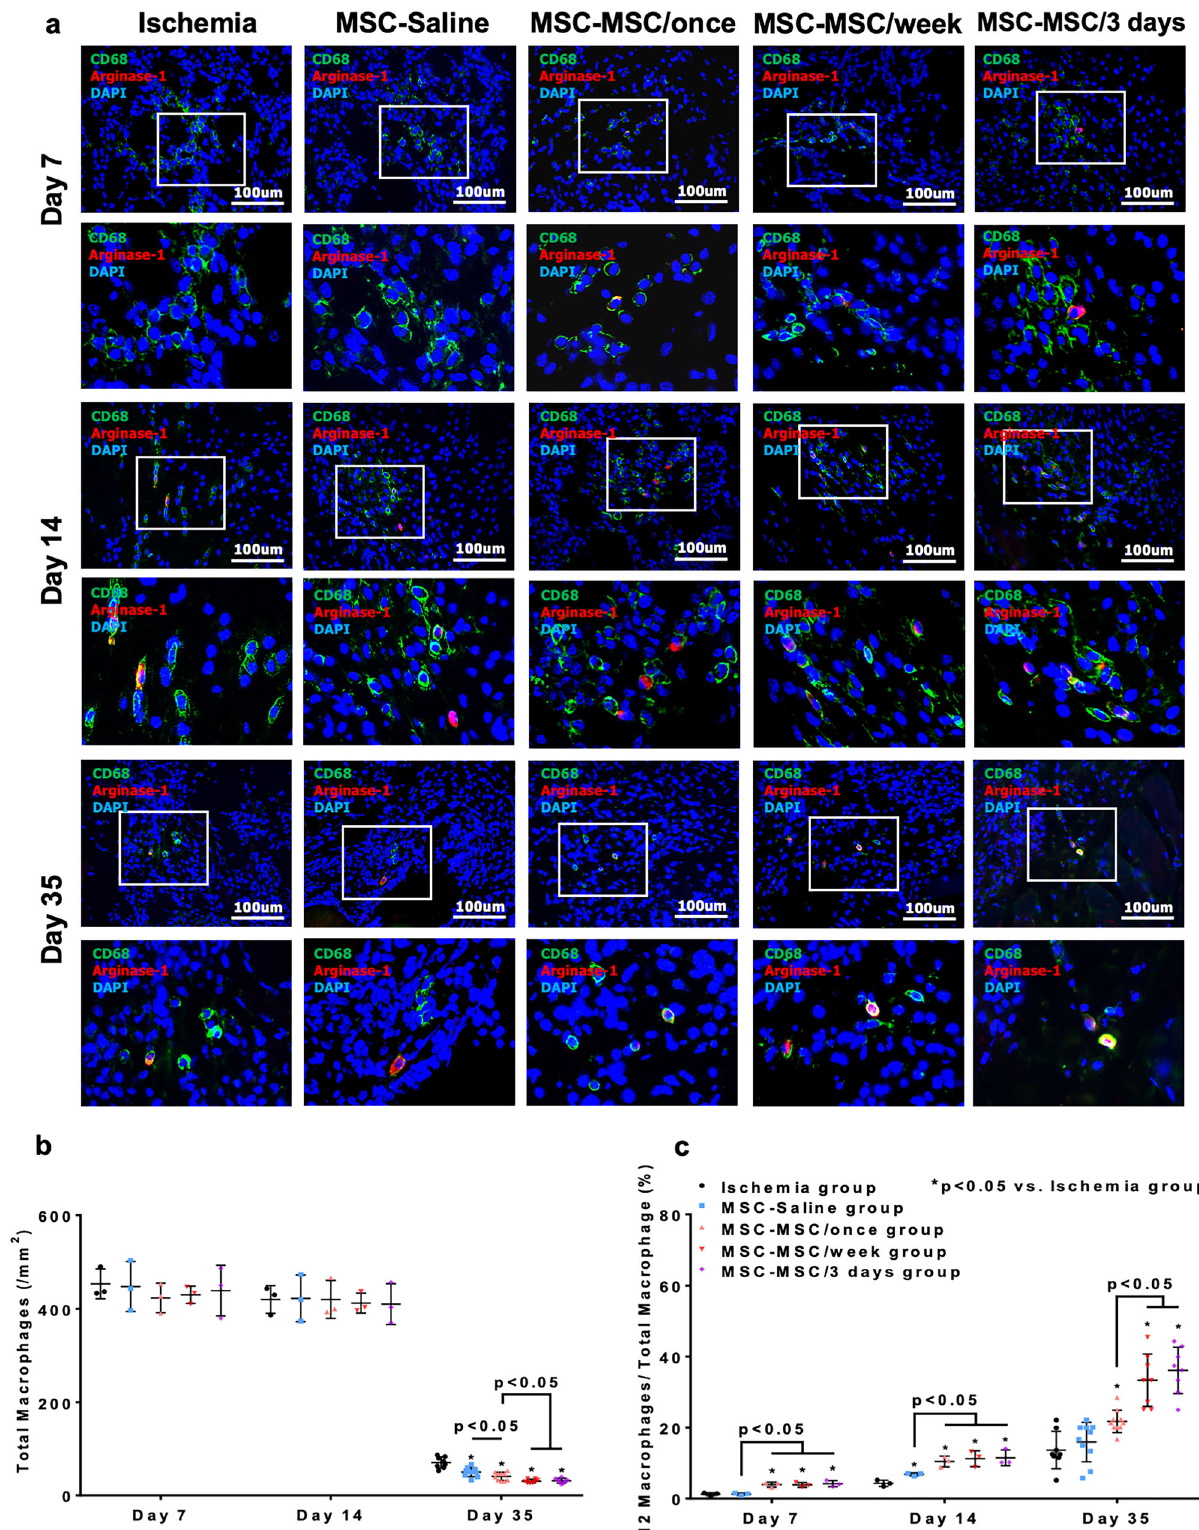
observed among all fi ve groups on day 35 (Supplementary Fig. 3b, all p <